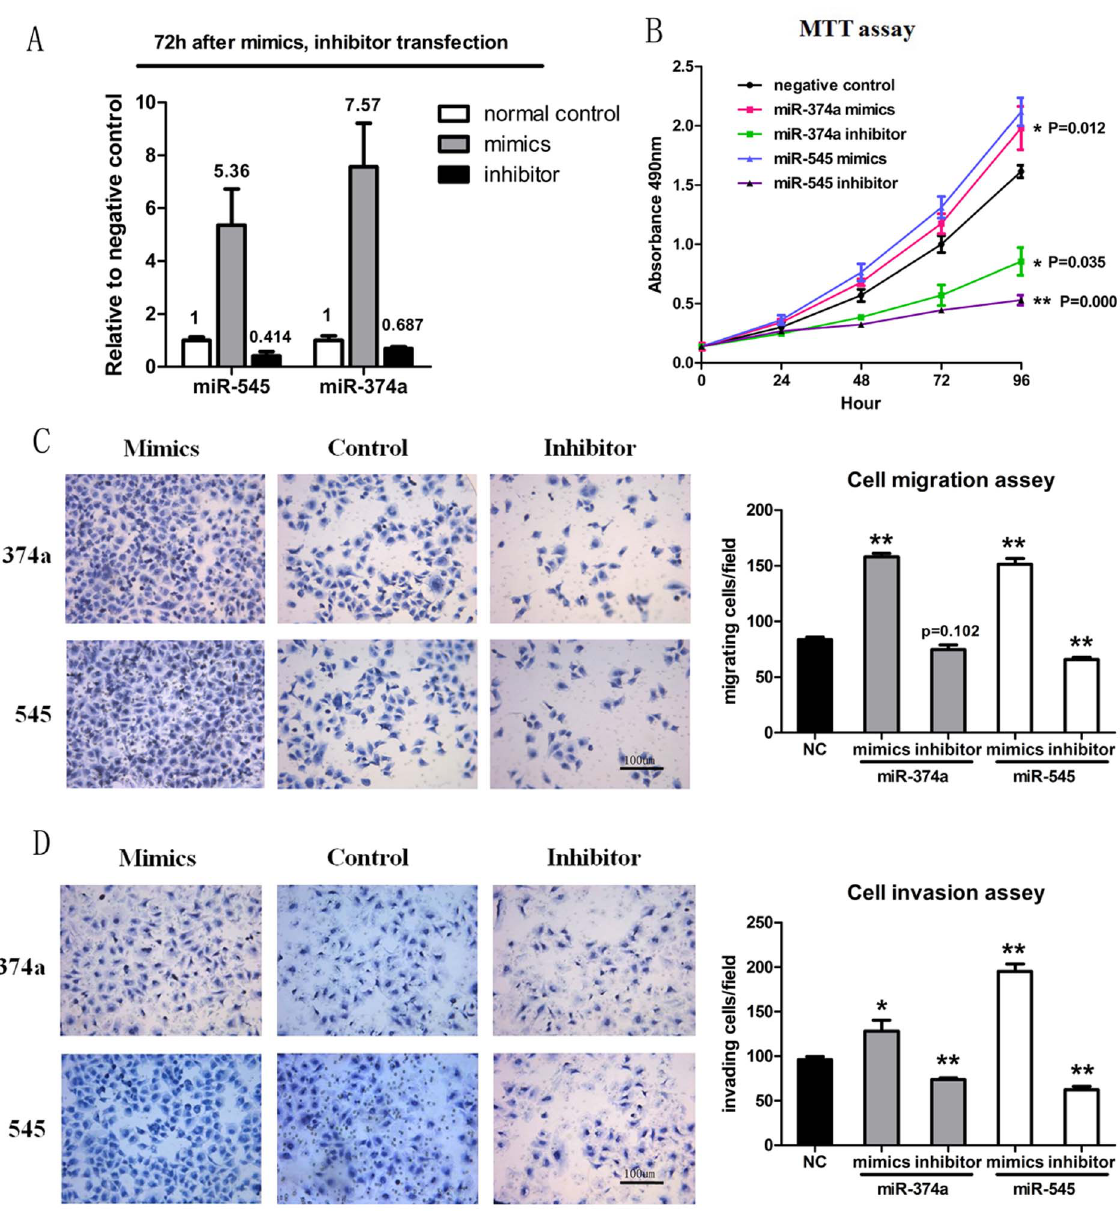
Figure 2. Functional analysis of miR-545 and miR-374a. (A) Expression status of miR-545 and miR-374a following transfection with microRNA mimics and inhibitors. The Bel-7402 cell line was transfected with individual microRNA mimics and inhibitors. Nonsense oligonucleotide was transfected as a negative control. The microRNA expression status at 72 h after transfection was monitored by quantitative RT-PCR. Experiments in A were repeated at least 3 times with similar results, and error bars represent mean 6 Std. deviation. (B) Bel-7402 cells were transfected as described in figure 2A and a MTT cell proliferation assay was performed. Experiments in B were repeated at least 3 times with similar results, and error bars represent mean 6 Std. deviation. (C) Bel-7402 cells were transfected as described in figure 2A and cell migration assays using transwell membranes were performed. Representative pictures of migration chambers, and average counts from five random microscopic fields are shown. Experiments in C were repeated at least 3 times with similar results, and error bars represent mean 6 Std. deviation. (D) Bel-7402 cells were transfected as described in figure 2A and cell invasion assays using Matrigel-coated transwell membranes are shown. Representative pictures of invasion chambers, and average counts from five random microscopic fields are shown. Experiments in D were repeated at least 3 times with similar results, and error bars represent mean 6 Std. deviation. *P , 0.05, **P , 0.01, t test. doi:10.1371/journal.pone.0109782.g002 higher miR-545/374a level than AFP negative patients (p =0.012, metastasis. Next, 3 previously established clinical features p = 0.009, independent t test) (figure 5B). However, no significant forecasting HCC recurrence (AFP, CEA, and c -GT) were differences in the levels of miR-545/374a were observed for patients expressing CEA or c -GT (figure S1B). analyzed along with serum miR-545/374a expression (figure 5B, figure S1B). AFP positive patients ( $ 20 ng/ml) had a significantly